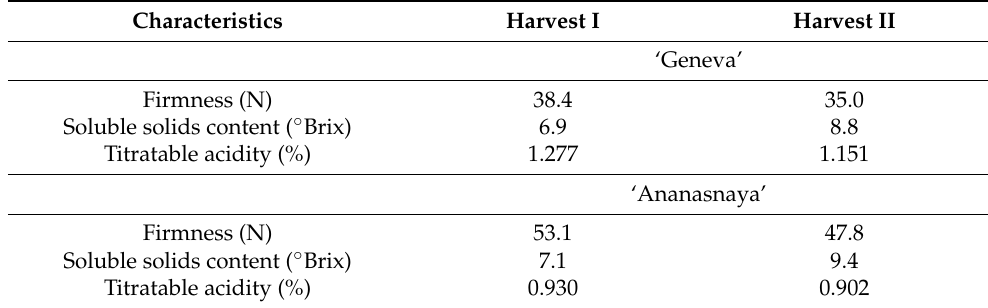
Table 1. Characteristics of ‘Geneva’ and ‘Ananasnaya’ mini kiwi assessed directly after